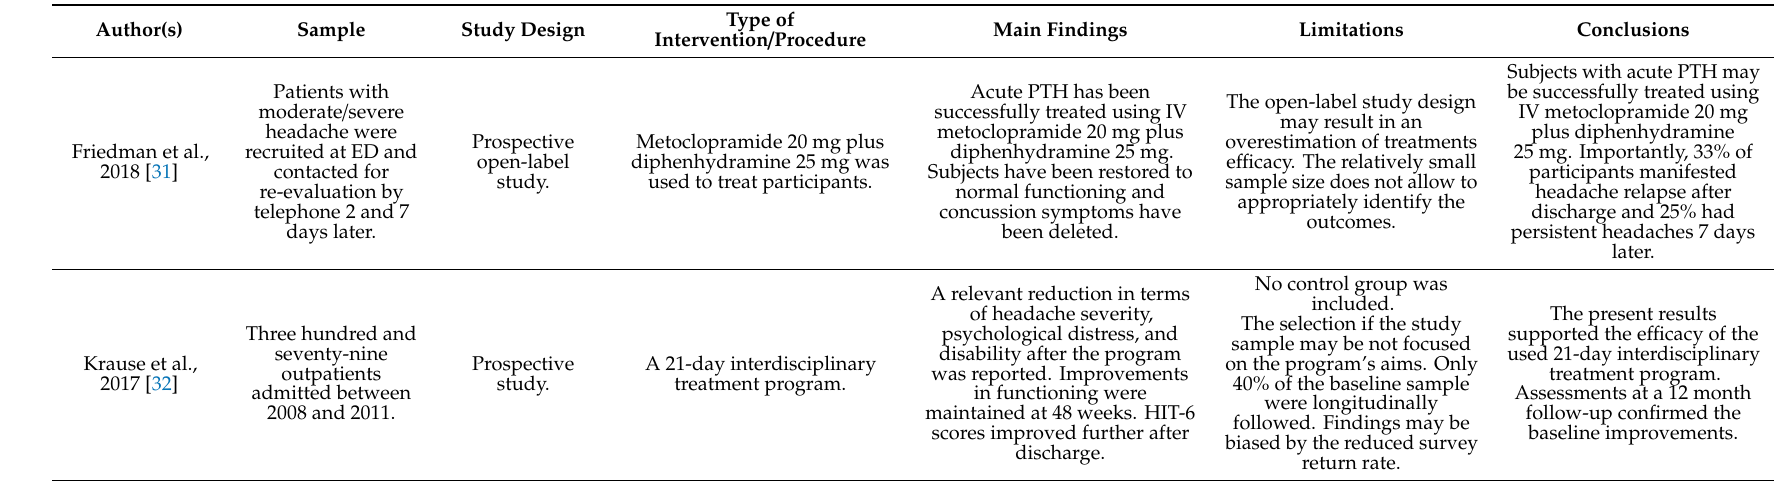
Table 3. Most relevant clinical studies reporting the importance of currently available treatments in persistent post-traumatic